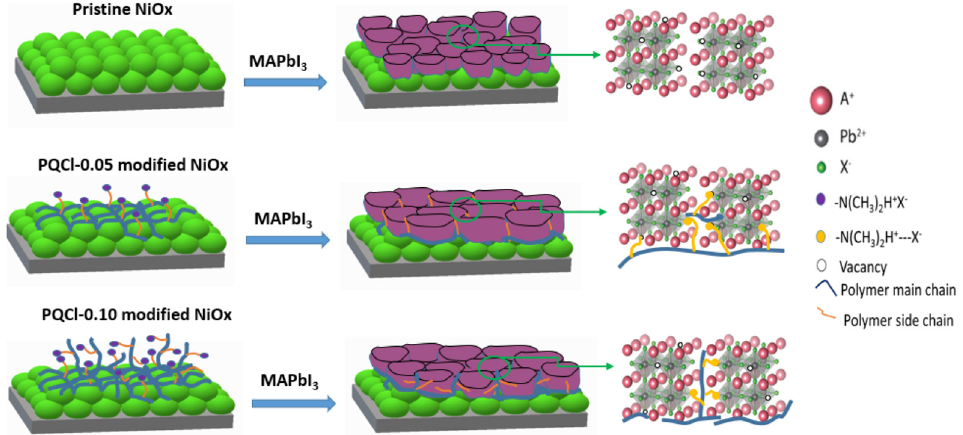
Figure 6. Schematic representation of crystal growth of MAPbI 3 films on cellulose derivative PQCl– modified NiO x -based HTLs.